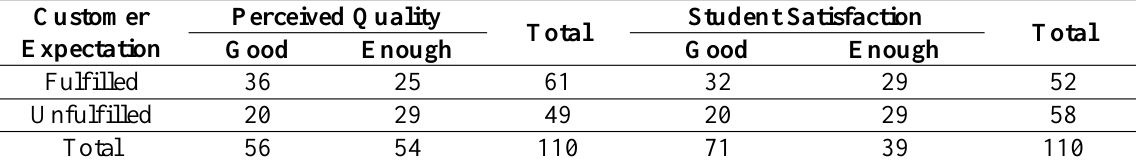
Table 2. Cross-tabulation result of Customer Expectation, Perceived Quality, and Student Satisfaction Customer